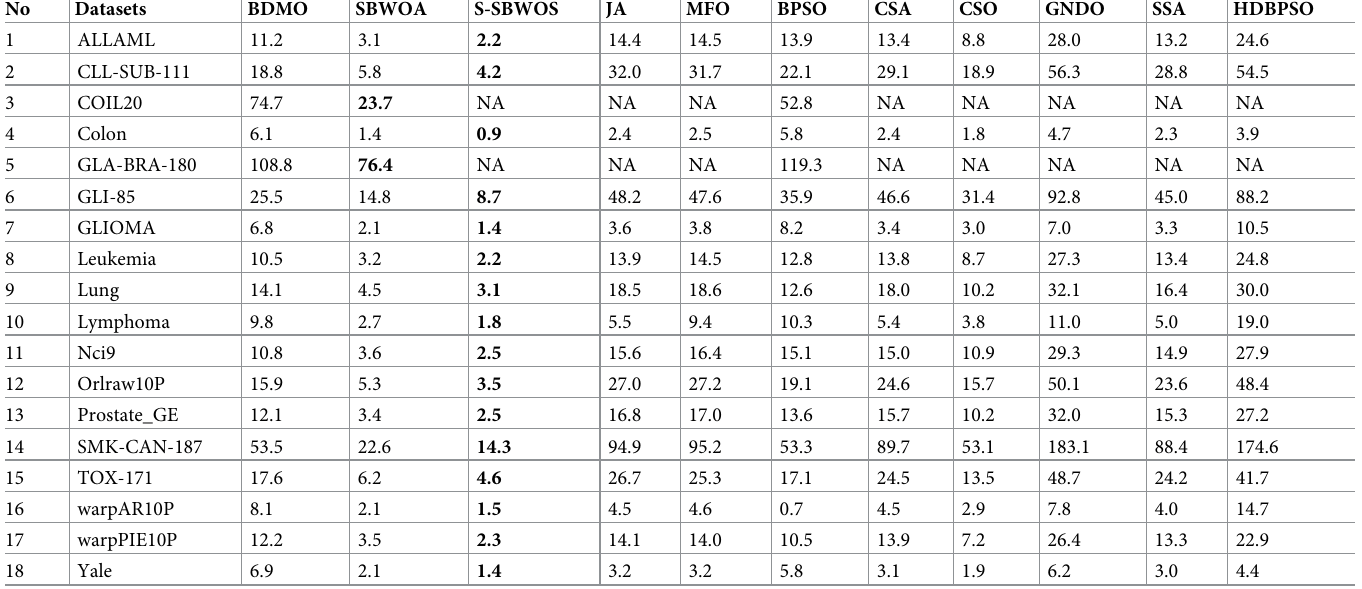
Table 5. Average time of computation of BDMO and other approaches (in